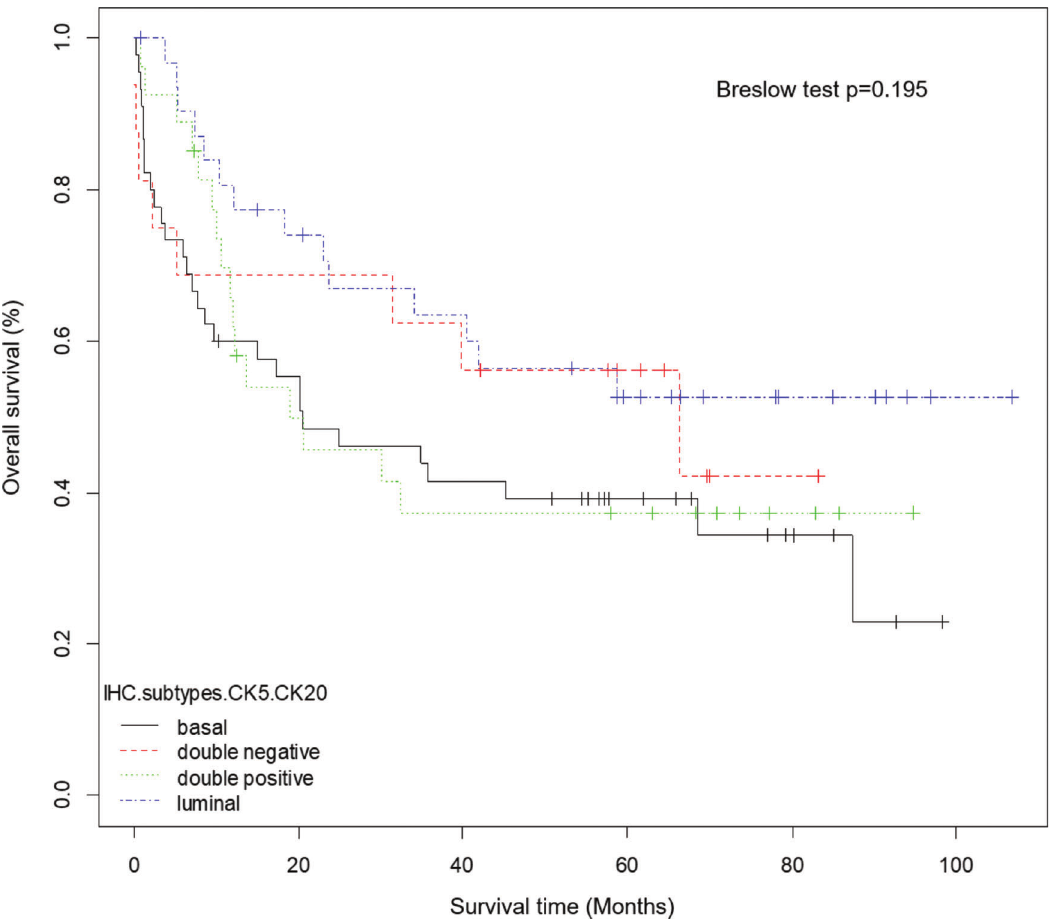
Figure 2 - Overall survival of 120 patients treated with radical cystectomy for MIUCB. Kaplan-Meier curves showing no difference based on IHC subtypes using CK5 and CK20 (Breslow test p